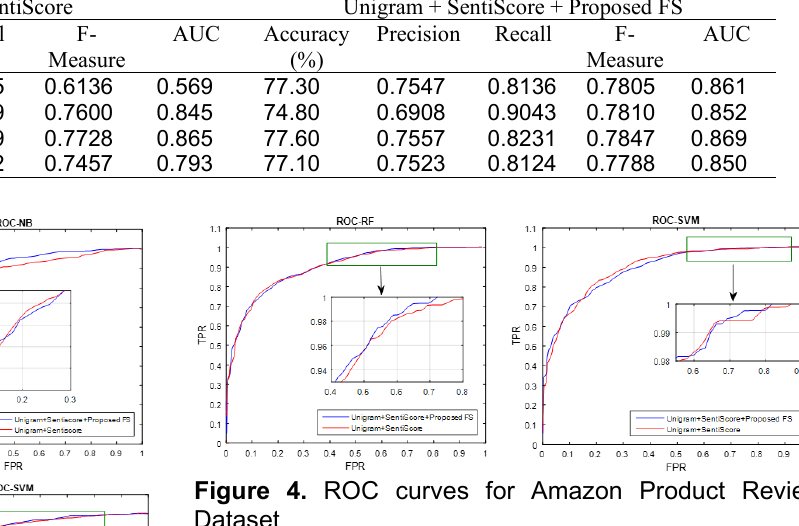
Table 8. Results of the proposed model for Yelp Restaurant review data set